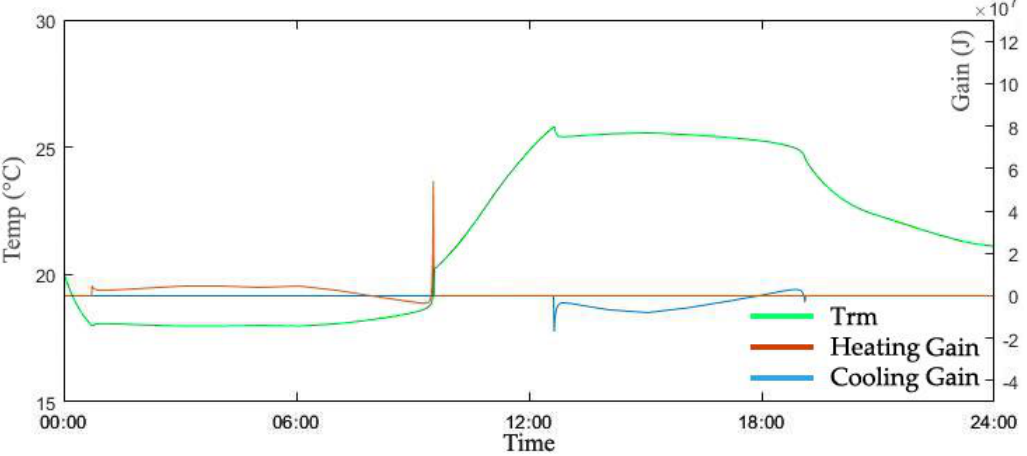
Figure 8. Changes of T rm and energy transfer by the Artificial Neural Network (ANN) control.